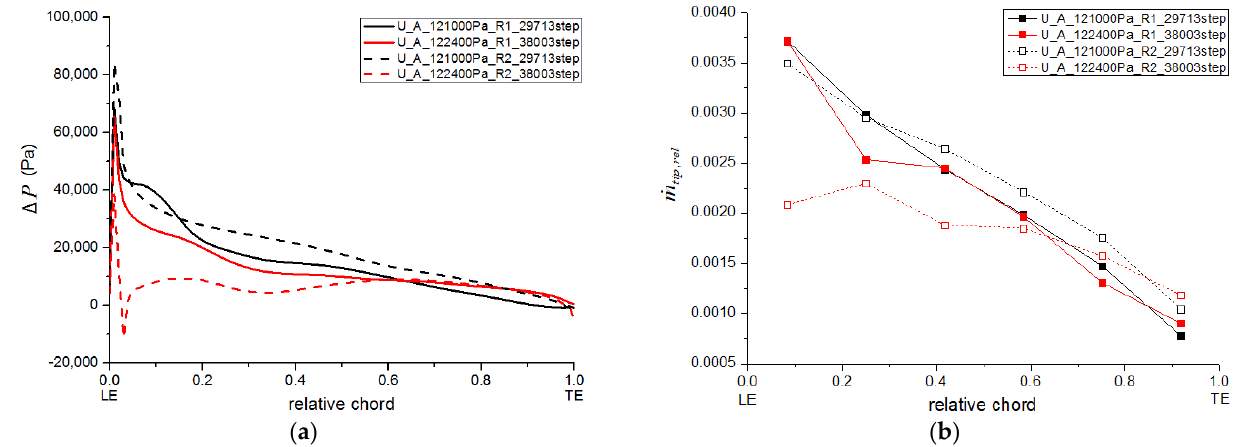
Figure 15. Blade load and corresponding leakage along chord under unsteady conditions. ( a ) Blade load and ( b ) corresponding leakage flow.